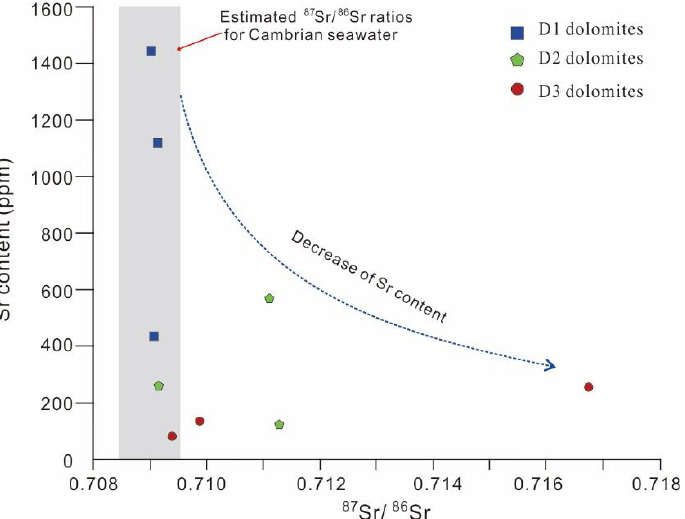
Figure 9. Cross-plot of 87 Sr/ 86 Sr versus Sr abundance for D1, D2, and D3 dolomites in the Cambrian successions, Bachu area, Tarim Basin. The strontium isotope range of coeval seawater marked in gray refers to Veizer et al. (1999) [45,46].